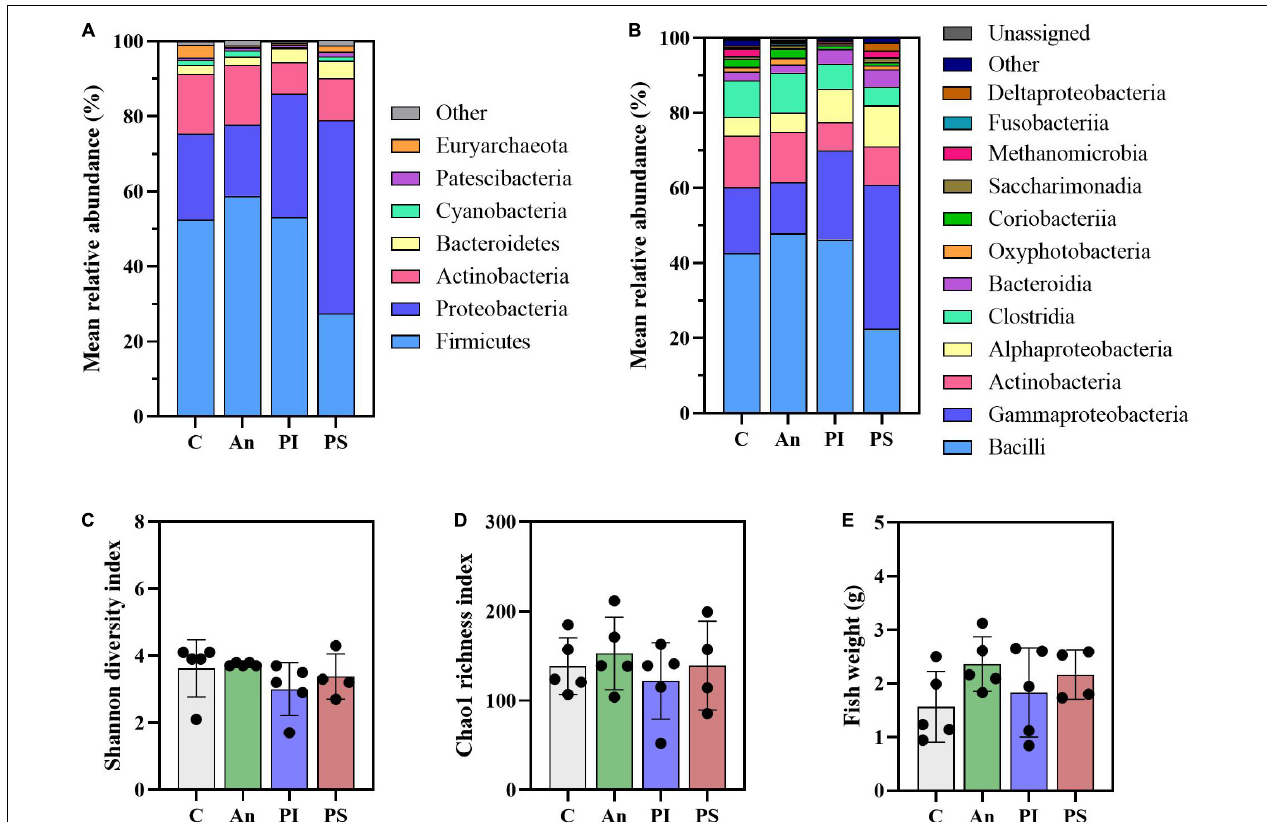
FIGURE 2 | Microbial community (day -1). Characterization of mean relative abundance at phylum (A) and class (B) level, Shannon diversity index (C) , Chao1 richness index (D), and fish weight (E) . Values represent the mean of five samples except for group fed with phage-sprayed feed ( n = 4). In (C–E) , error bars represent the standard deviation. Shannon diversity index values are based on 10,000 reads per sample. C, control feed group; An, antibiotic feed group; PI, phage-immobilized feed group; PS, phage-sprayed feed